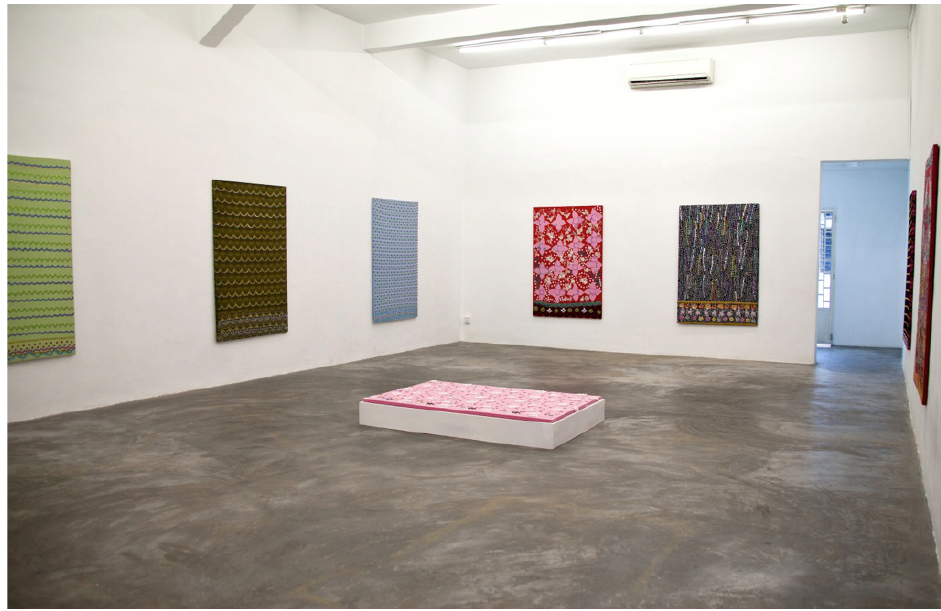
Chan Dany, Sampot: The Collection of Small Things , SA SA BASSAC, Phnom Penh. Installation view. Photograph by Lim Sokchanlina. Courtesy of the artist and SA SA